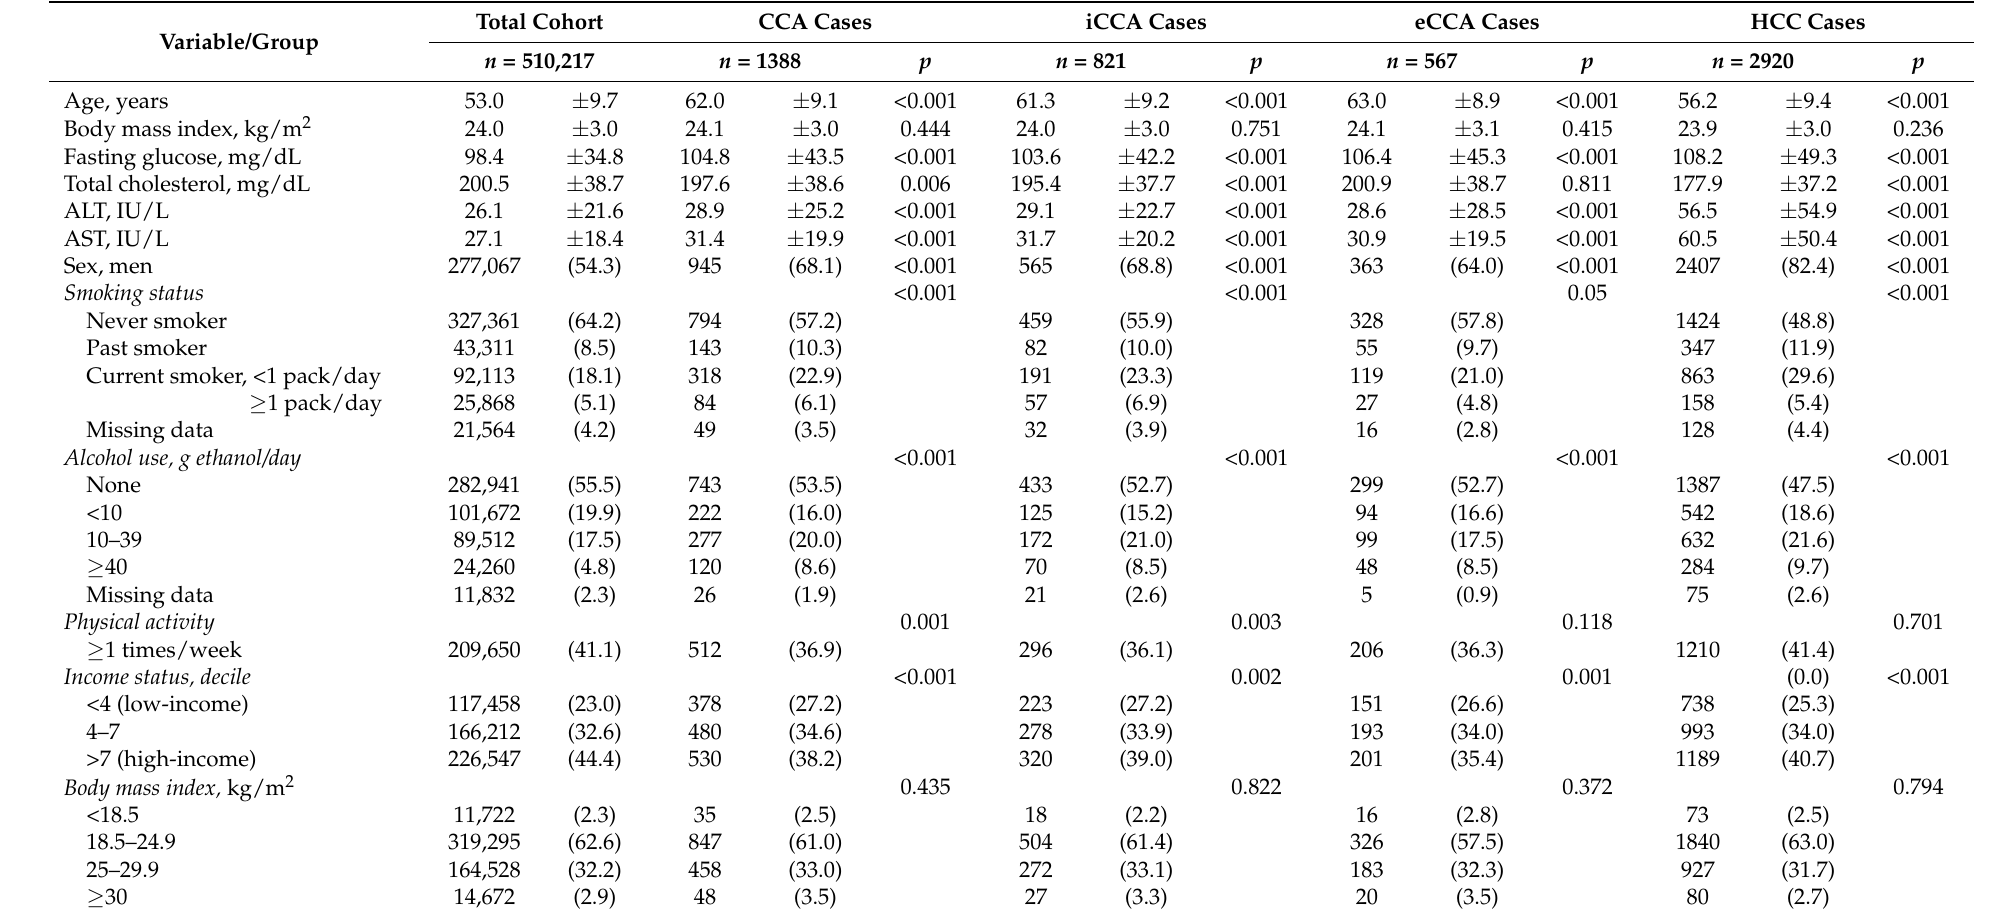
Table 1. Baseline characteristics of study